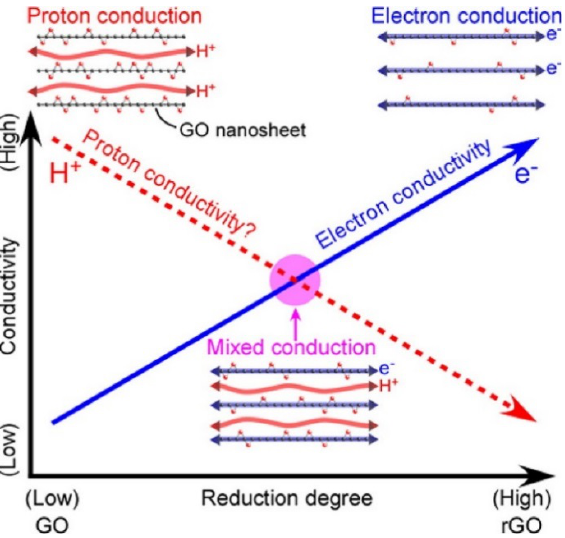
Figure 24. The concept behind the degree of GO reduction, which increases the electronic conductivity but decreases the protonic one. Reprinted with permission from Ref. [204]. Copyright 2014 American Chemical Society.